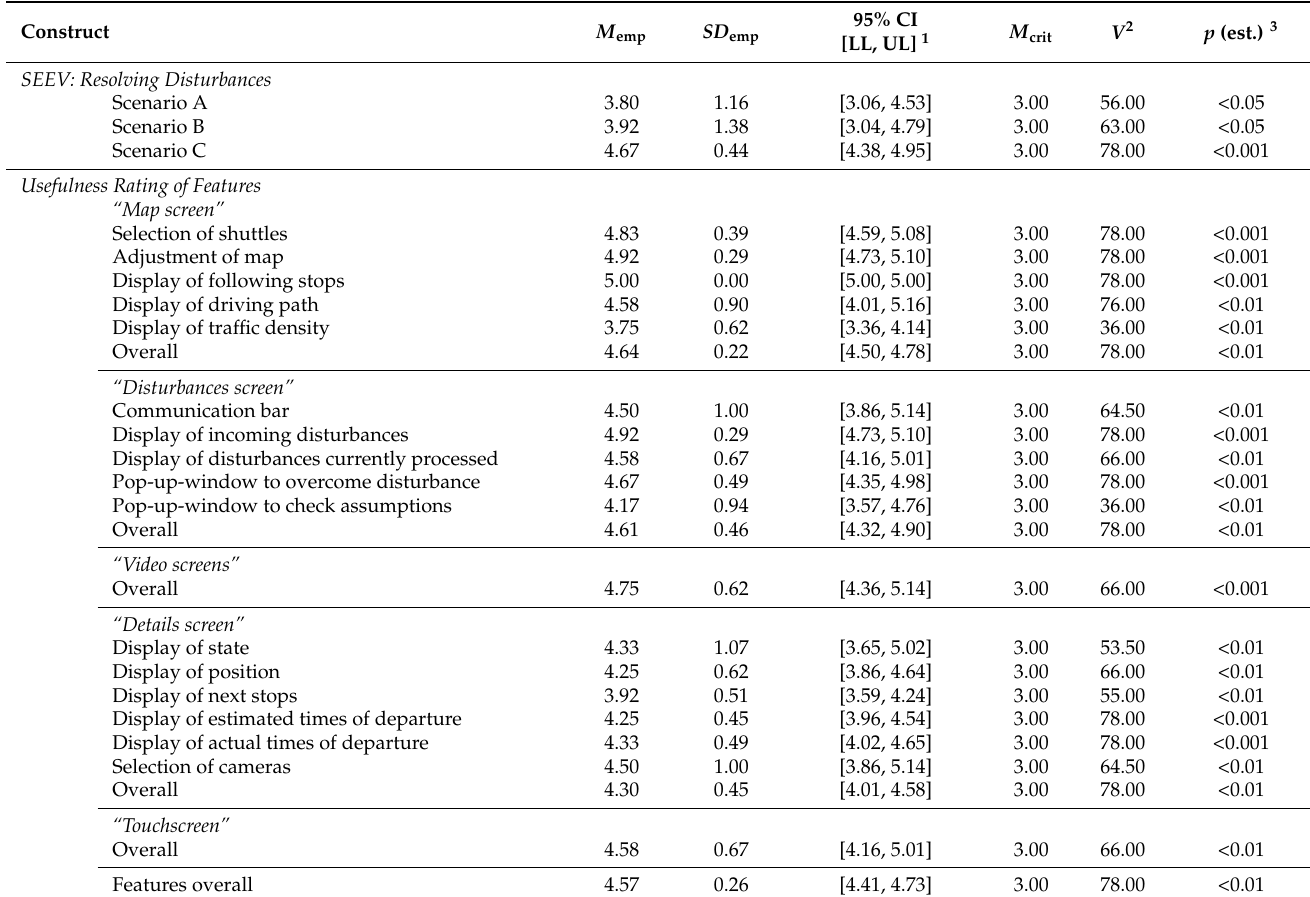
Table 2. Descriptive and inferential statistics regarding the criterion